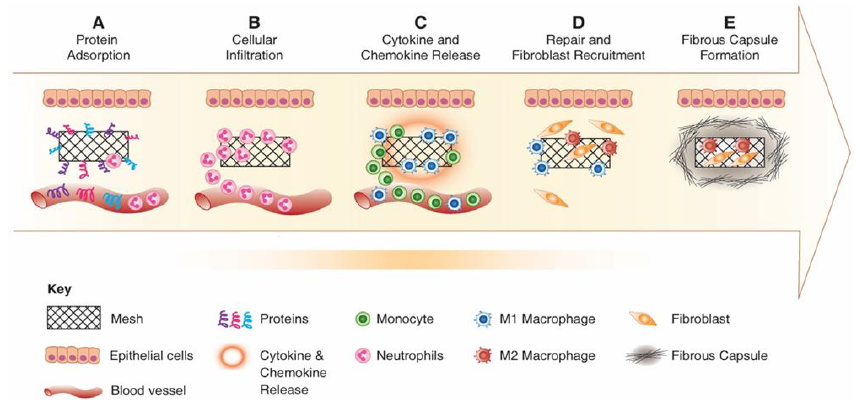
Figure 8. Schematic showing the foreign body response to an implanted inert biomaterial in the host’s body. Reproduced with permission of [101]. body. ( A ) Protein adsorption; ( B ) cellular infiltration and acute inflammation; ( C ) chronic inflammation, ( E ) formation of fibrous capsule. Reproduced with permission of